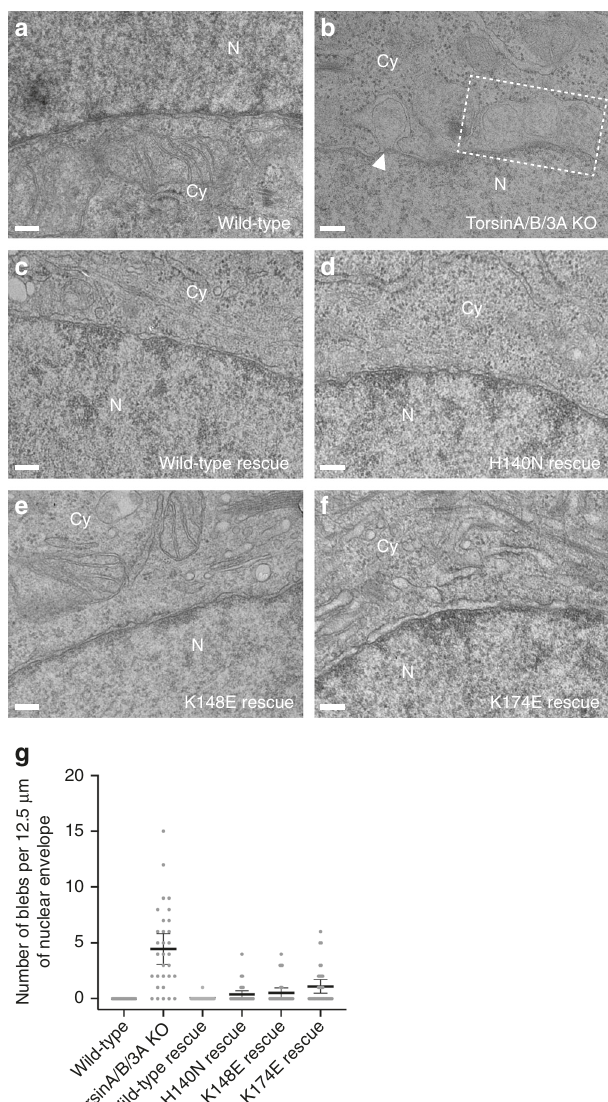
Fig. 4 TorsinA mutants and the blebbing at the nuclear envelope. Representative EM cross-sections of ( a ) a wild-type HeLa cell, ( b ) a triple TorA/B/3A knockout HeLa cell, and ( c – f ) the triple TorA/B/3A knockout HeLa cells rescued by stable expression of the TorsinA variants. Dashed box area encloses multiple blebs, and the white arrowhead marks the electron density observed at the curvature of the bleb neck. N nucleus, Cy cytoplasm. Scale bar, 150 nm. g Scatter plot of the number of blebs observed per EM cross-section (average NE membrane in each cross- section: 12.5 μ m) in HeLa cell lines. Thirty EM cross-sections per cell line were analyzed. Mean values are shown together with 95% con fi dence intervals